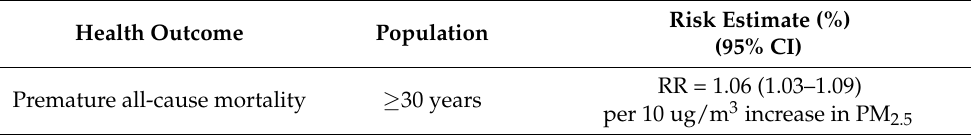
Table 1. Risk estimate from Krewski et al., 2009. Health Outcome Population Premature all-cause mortality ≥ 30 years